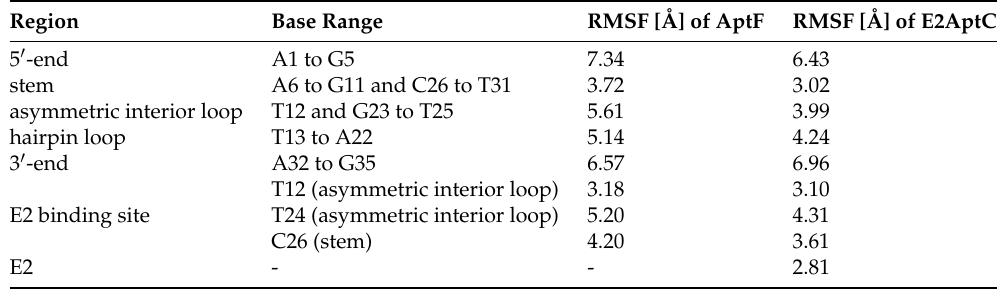
Table 1. Comparison of the RMSF values between AptF and E2AptC. The SSEs of the aptamers, their corresponding bases with identifier, E2, and their RMSF values in Å are displayed. AptF, aptamer-free; E2, 17 β -estradiol; E2AptC, E2-aptamer complex; RMSF, root mean square fluctuation; SSEs, secondary structure